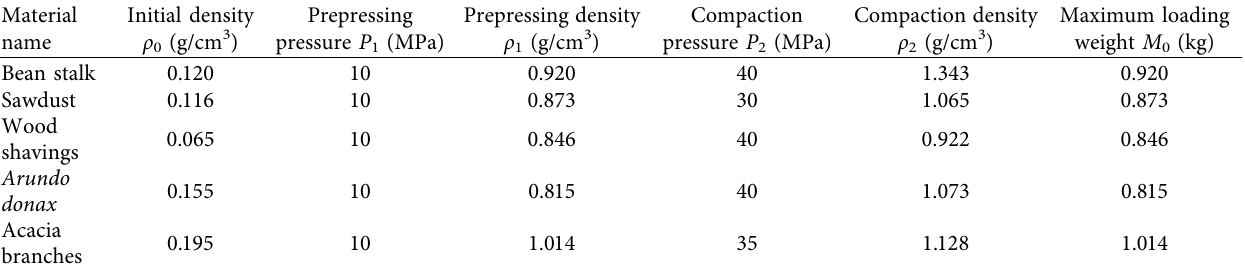
Table 1: The density and pressure of the key nodes during the compression process and the maximum loading weight of a single prepress cavity.